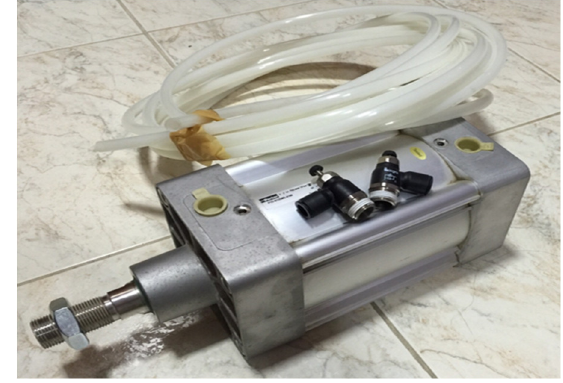
Fig. 8: Double acting pneumatic